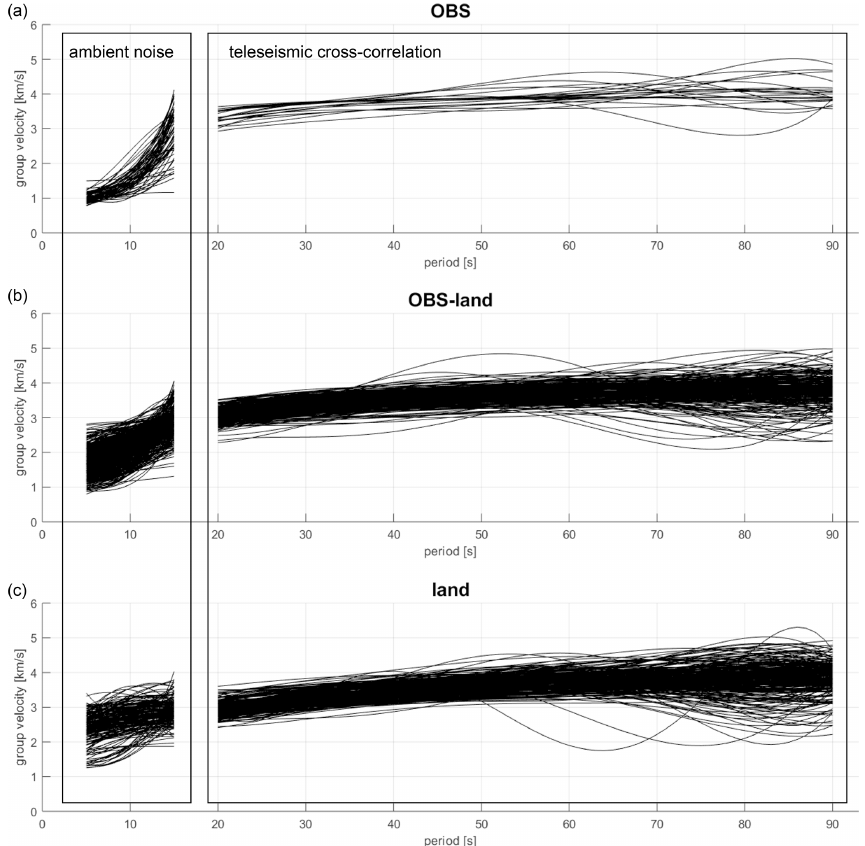
Figure 5. Picked dispersion curves from ambient noise cross-correlation and correlation of teleseismic events. The dispersion curves are sorted for different types of station pairs: (a) OBS–OBS pairs, (b) OBS–land pairs and vice versa, (c) land–land